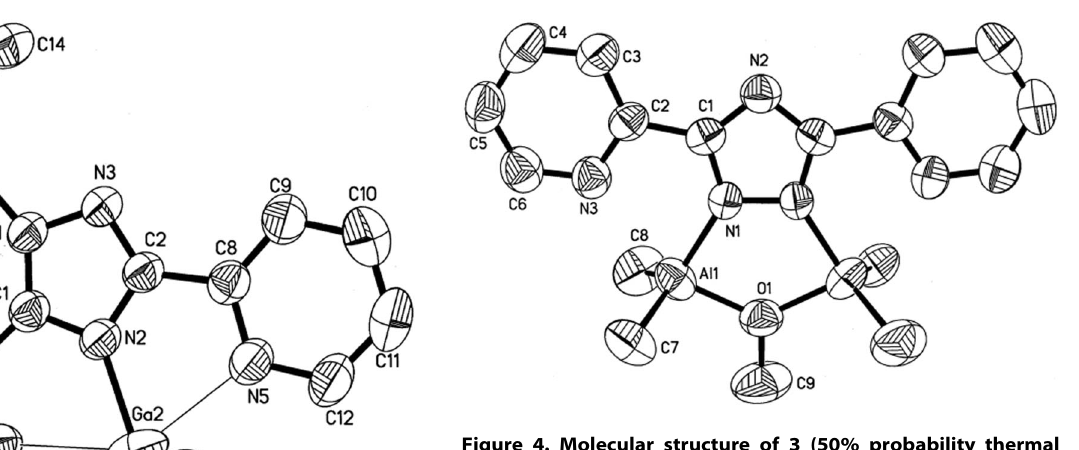
Figure 4. Molecular structure of 3 (50% probability thermal ellipsoids).